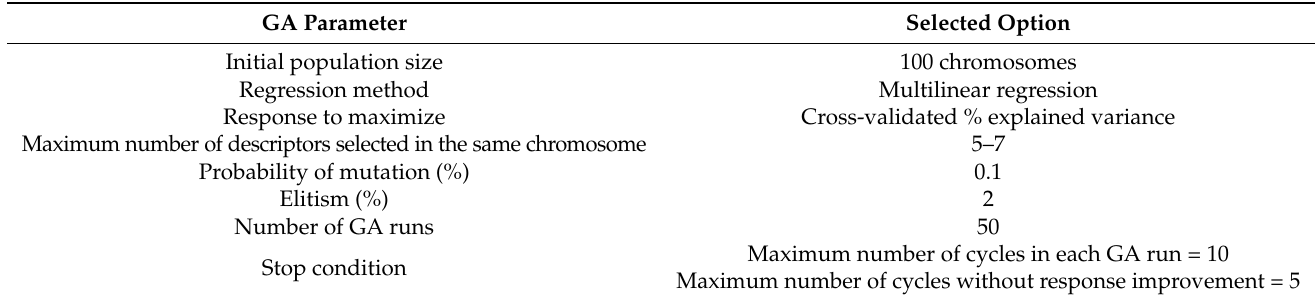
Table 1. Parameters used in GA analysis.